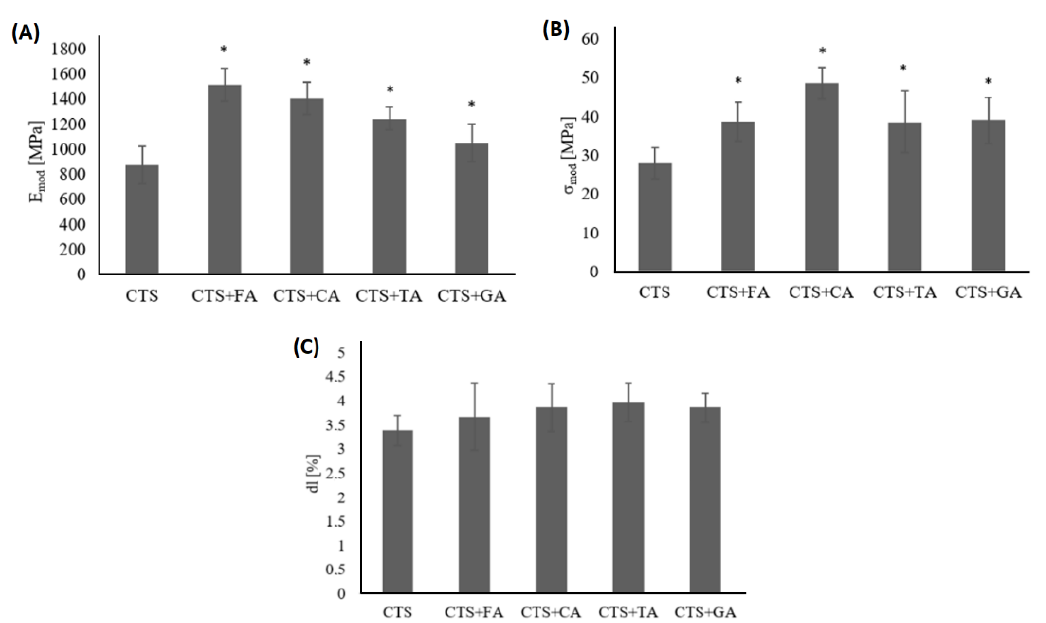
Figure 1. The mechanical parameters, such as: ( A ) Young modulus (E mod ), ( B ) maximum tensile strength ( σ mod ) and ( C ) elongation at break (dl) determined for each type of sample (* significantly different from control—CTS— p < 0.05).